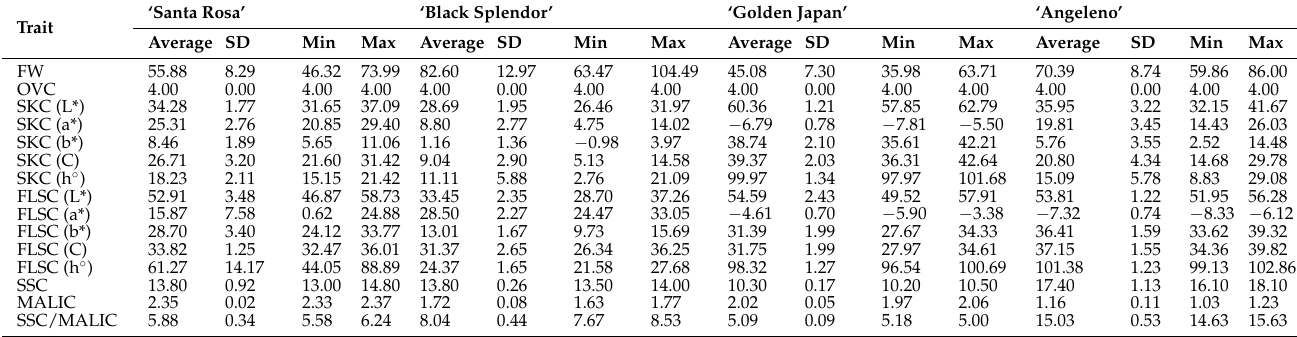
leno’ displayed differences between treatments on the last day of phenotyping (day 24) (Figure S2), with it’s flesh color turning from yellow to red. In terms of fruit firmness and ethylene evolution of the evaluated cultivars, ‘Santa Rosa’ recorded the most significant differences in fruit firmness and ethylene emission, exhibiting a maximum ethylene peak on day 4 (Figure 2). On the other hand, ‘Angeleno’ was the most suppressed-climacteric cultivar, even without 1-MCP application (no ethylene emission) or after Ethrel treatment (low ethylene emission only after 21 days). Therefore, the ‘Santa Rosa’ cultivar was selected for further analysis. Table 3. Descriptive statistic of fruit quality traits in Japanese plum cultivars at harvest time. FW: fruit weight (g); OVC: over color (1–4); SKC: skin color (CIE L*, a*, b*, C and h ◦ ); FLSC: flesh color (CIE L*, a*, b*, C and h ◦ ); SSC: soluble solid content (%); MALIC: malic acid content (g 100 mL − 1 ); SSC/MALIC: soluble solid and malic acid content